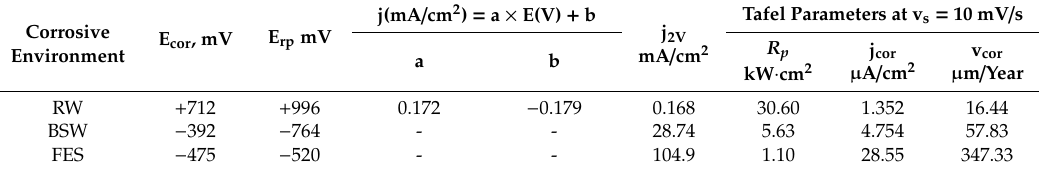
Figure 2. Cyclic voltammograms for the I-Zn sample. Table 7. Stimulated corrosion parameters for the I-Zn sample in the three corrosive environments. Corrosive